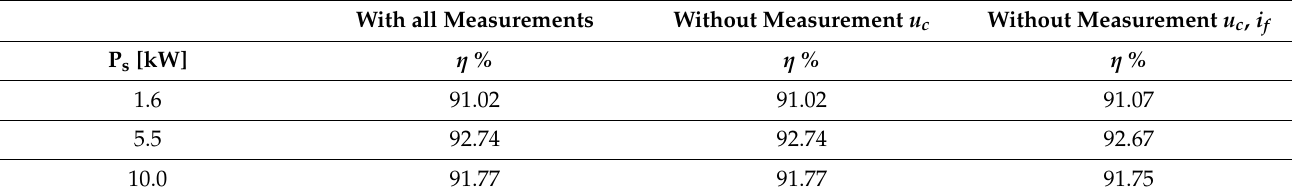
Table 2. Total efficiency of generator